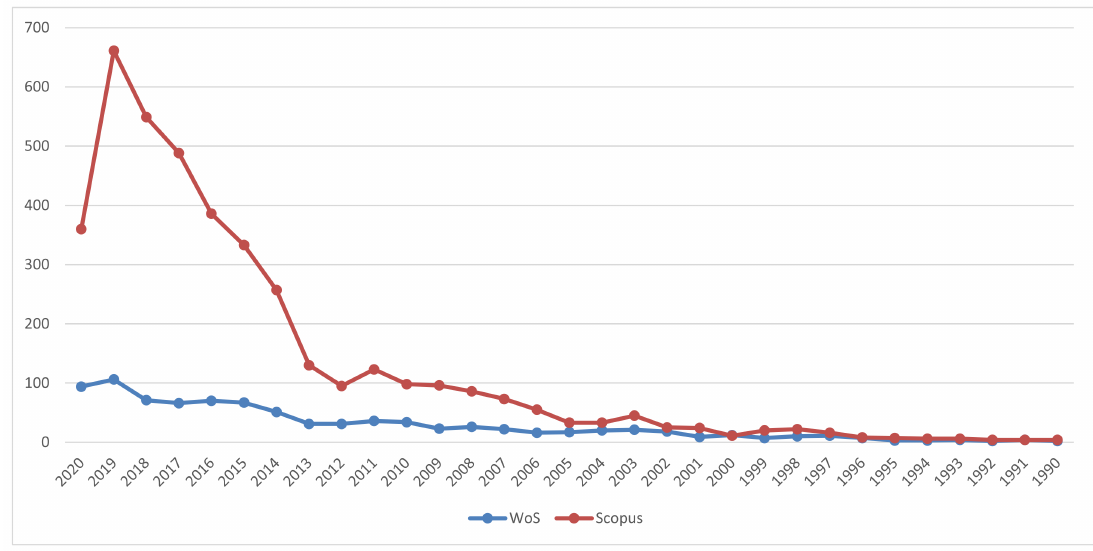
Figure 1. Evolution of the number of records (documents) over the last decades in the WoS and Scopus databases.